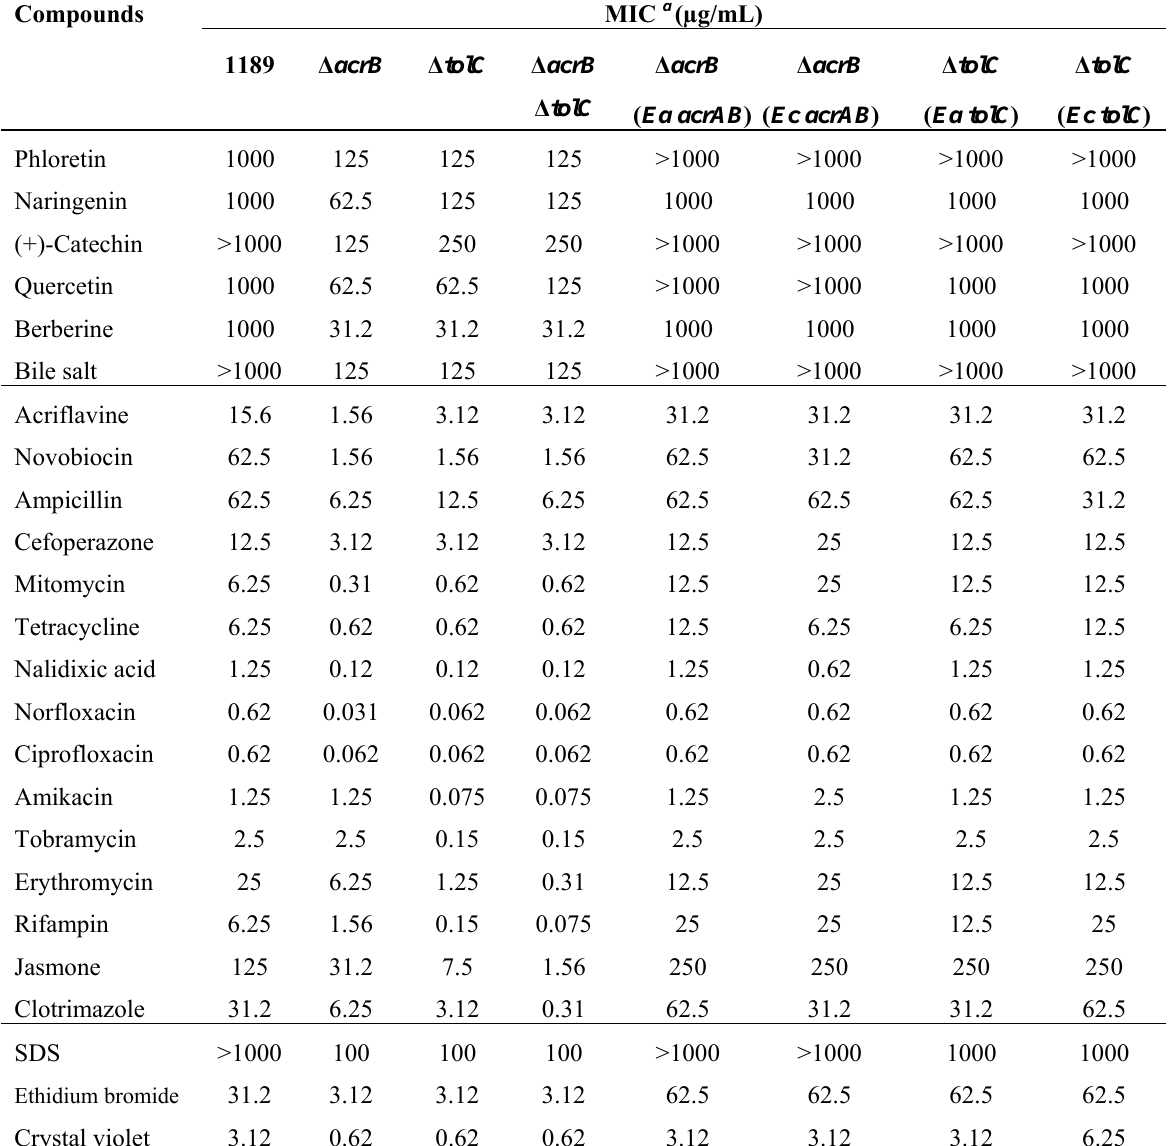
Table 4. Susceptibility of Erwinia amylovora strains to different compounds in minimal medium